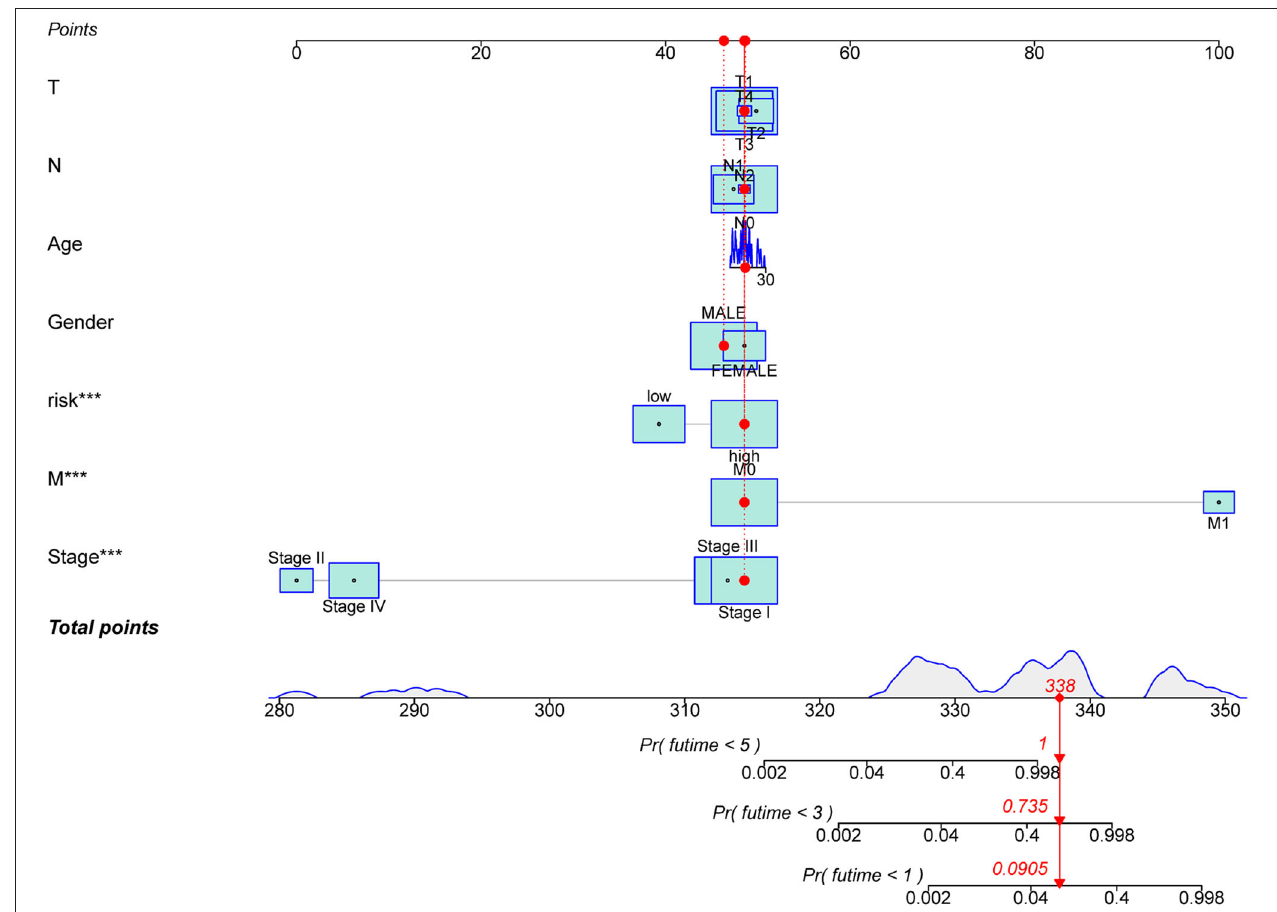
FIGURE 5 | A nomogram for the ferroptosis-related lncRNAs with prognostic value and the clinicopathological factors of patients with pRCC. *** p < 0.001.